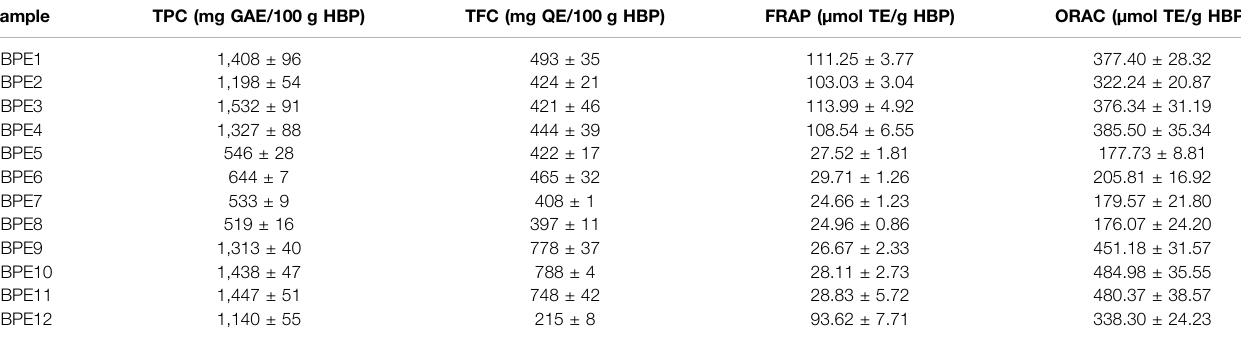
TABLE 2 | Average values of total phenolic content (TPC), total fl avonoids content (TFC), FRAP, and ORAC-FL in honeybee pollen extracts (HBPEs).